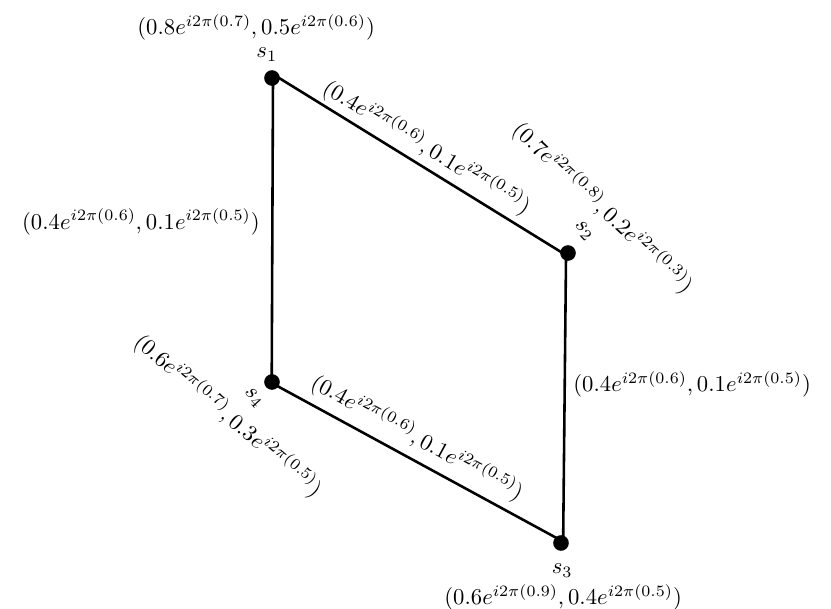
Figure 10. ( 1.2 e i 2 π ( 1.8 ) ,0.3 e i 2 π ( 1.5 ) ) -totally edge regular complex Pythagorean fuzzy graph. Figure 10: (1 . 2 e i 2 π (1 . 8) , 0 . 3 e i 2 π (1 . 5) )-totally edge regular complex Pythagorean fuzzy graph. Clearly, td G ( s 1 s 2 ) = td G ( s 2 s 3 ) = td G ( s 3 s 4 ) = td G ( s 4 s 1 ) = ( 1.2 e i 2 π ( 1.8 ) , 0.3 e i 2 π ( 1.5 ) ) . So, G is 275 ( 1.2 e i 2 π ( 1.8 ) , 0.3 e i 2 π ( 1.5 ) ) -totally regular